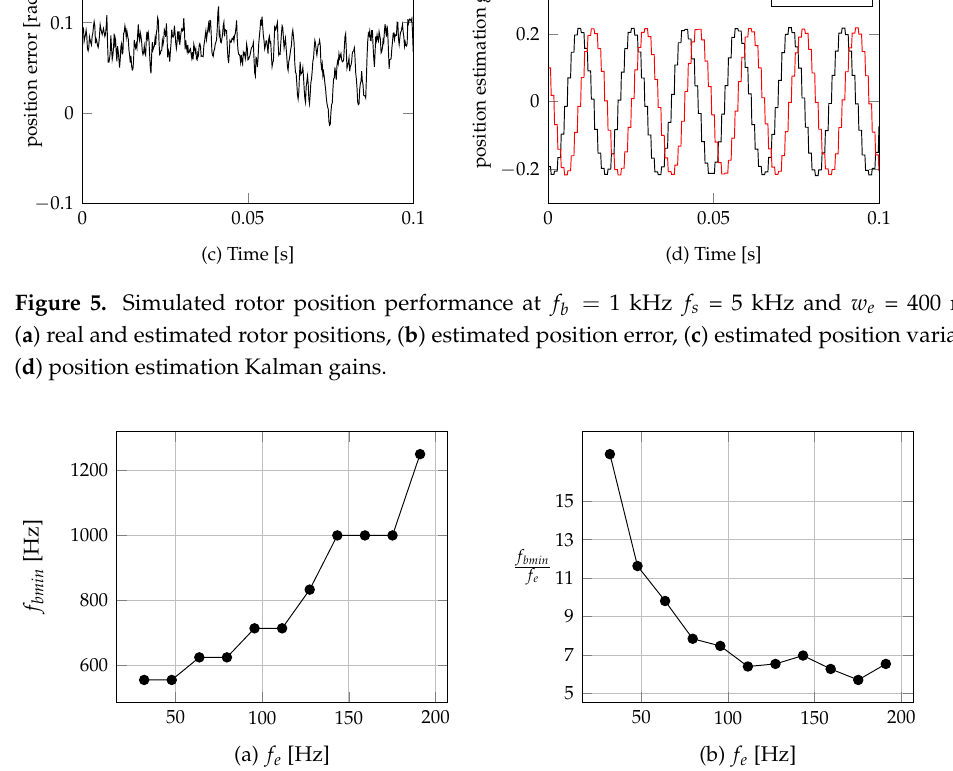
Figure 6. The relation between the minimum required Kalman matrices calculation frequency f bmin and the rotor electrical frequency f e . ( a ) the relation between minimum required f bmin and f e , ( b ) the relation between the ratio of f bmin to f e and the rotor electrical frequency f e